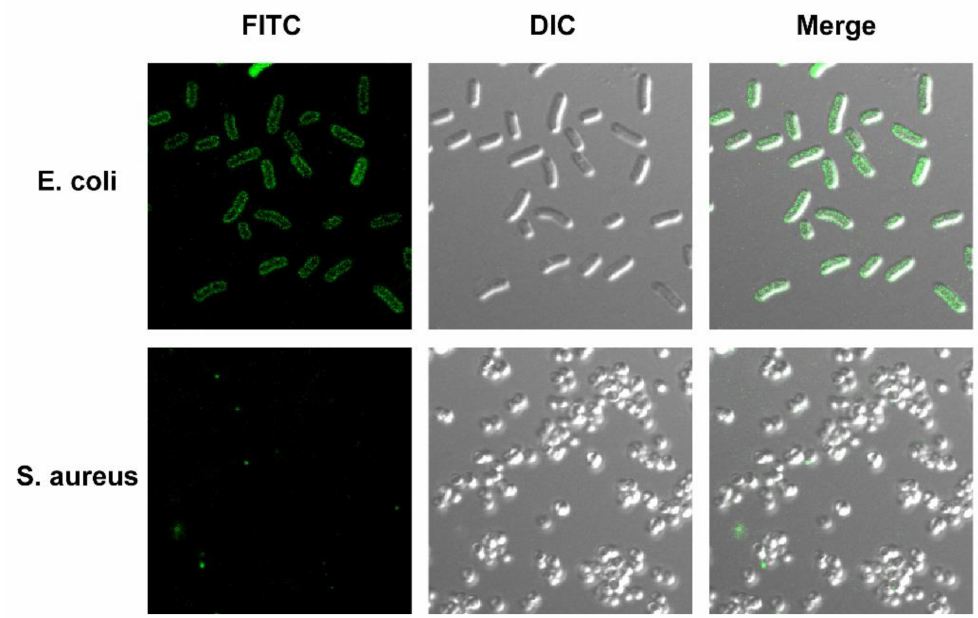
Figure 3. Fluorescence confocal laser scanning microscope of FITC-labeled antimicrobial peptide TS in E. coli cells for localization. E. coli ATCC 25922 and S. aureus ATCC 29213 treated with FITC-labeled antimicrobial peptide TS for 10